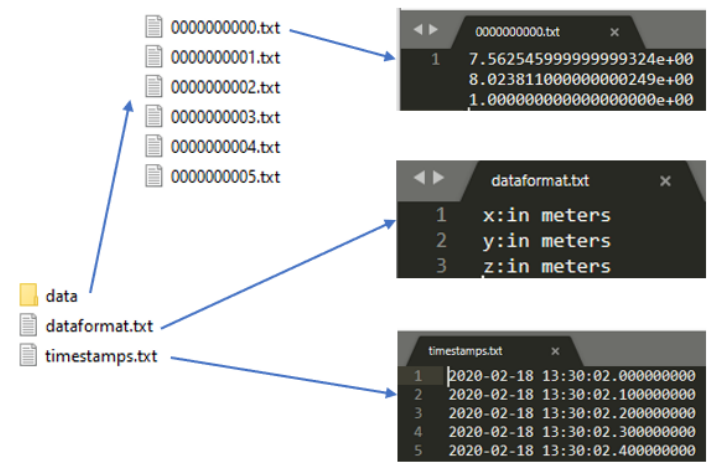
Figure 7. Snapshot of the dataset for Rig 1 Mocap _ raw